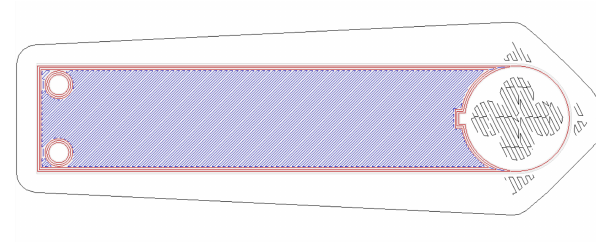
Figure 14: CAM view of the bottom part of the arm with perimeter beads in red, support in black and infill in